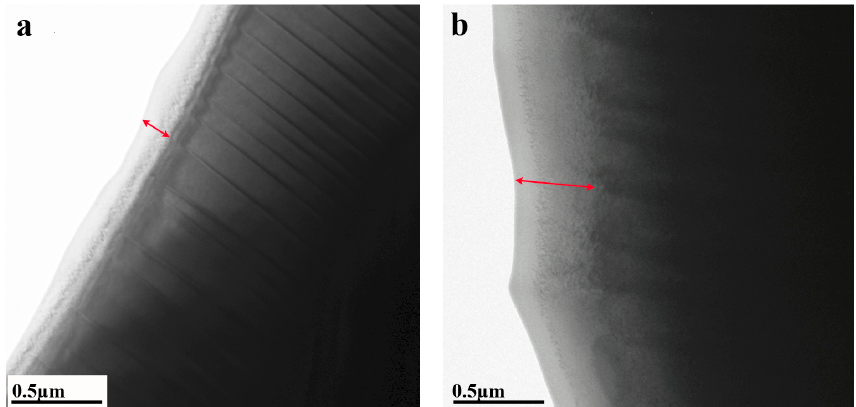
Figure 3. Bright field TEM images taken from the samples irradiated at doses ( a ) 10 13 and ( b ) 10 15 ions/cm 2 . The layer of disordered cubic U(Al, Si) 3 phase (which appeared due to the irradiation) is marked by an arrow. It can be clearly seen that the layer becomes thicker when the dose is higher.